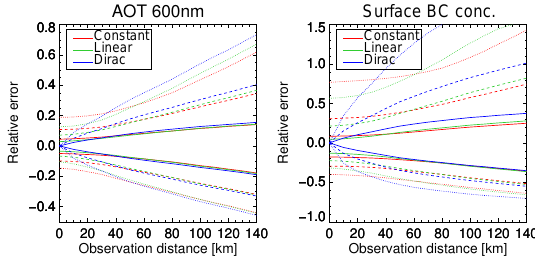
Figure 16. Relative spatial sampling error (monthly data) as a function of distance of the observation to the grid point, for three different weighting functions. Results from WRF-Chem MADE over W. Europe. The usual interquantile ranges (cid:49)q 50 (solid), (cid:49)q 82 (dashed) and (cid:49)q 96 (dotted) are